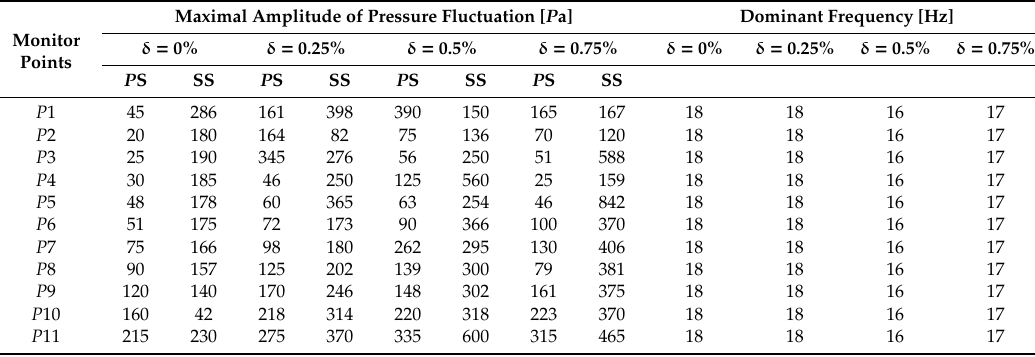
Table 3. Maximal pressure fluctuation magnitude and dominant frequency for various